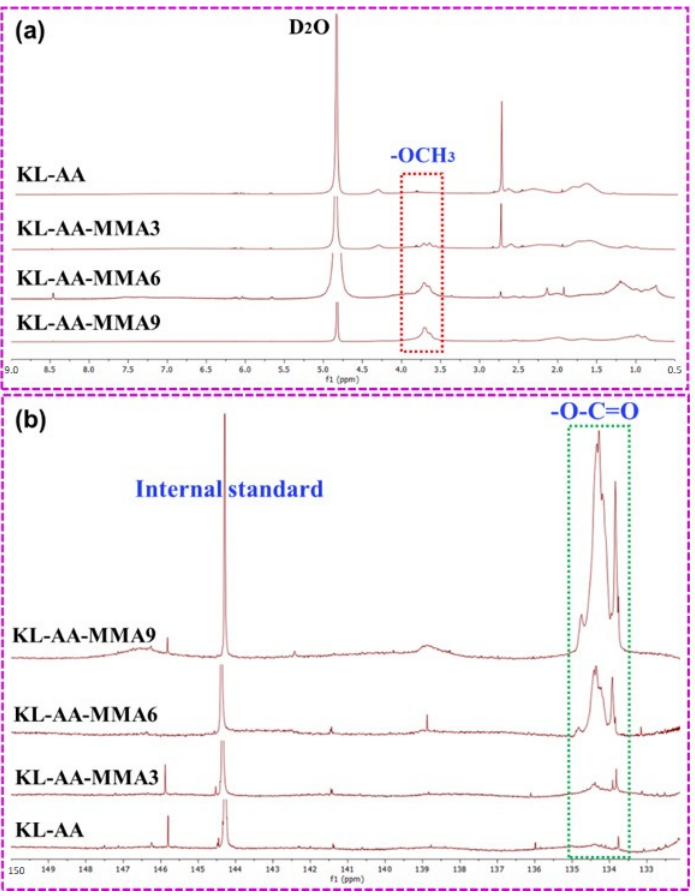
Figure 2. ( a ) 1 H-NMR and ( b ) 31 P-NMR spectra of the KL-AA and KL-AA-MMA copolymers.